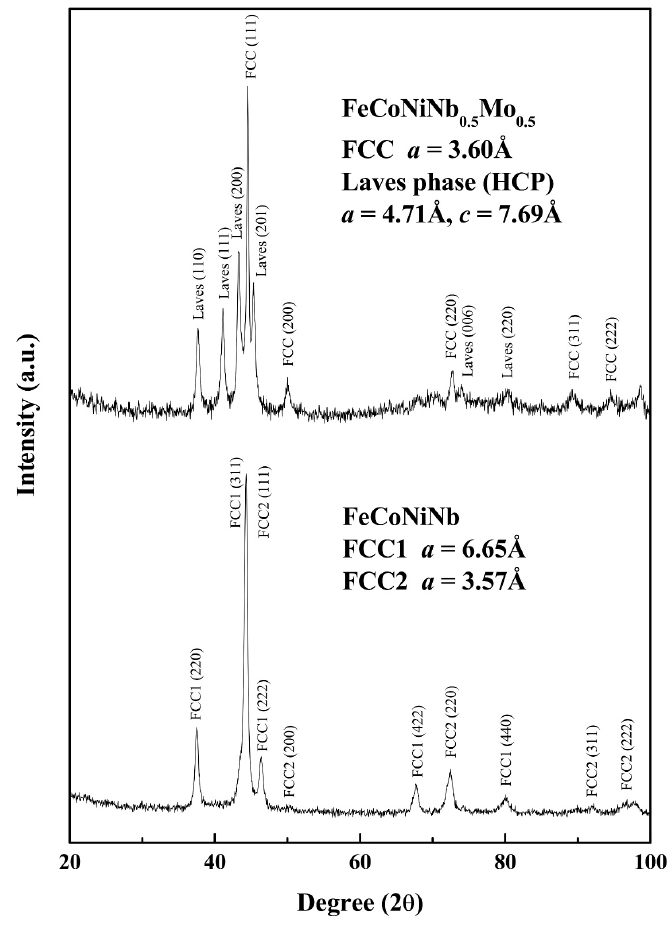
Figure 2. XRD patterns of FeCoNiNb 0.5 Mo 0.5 alloy and FeCoNiNb alloy.